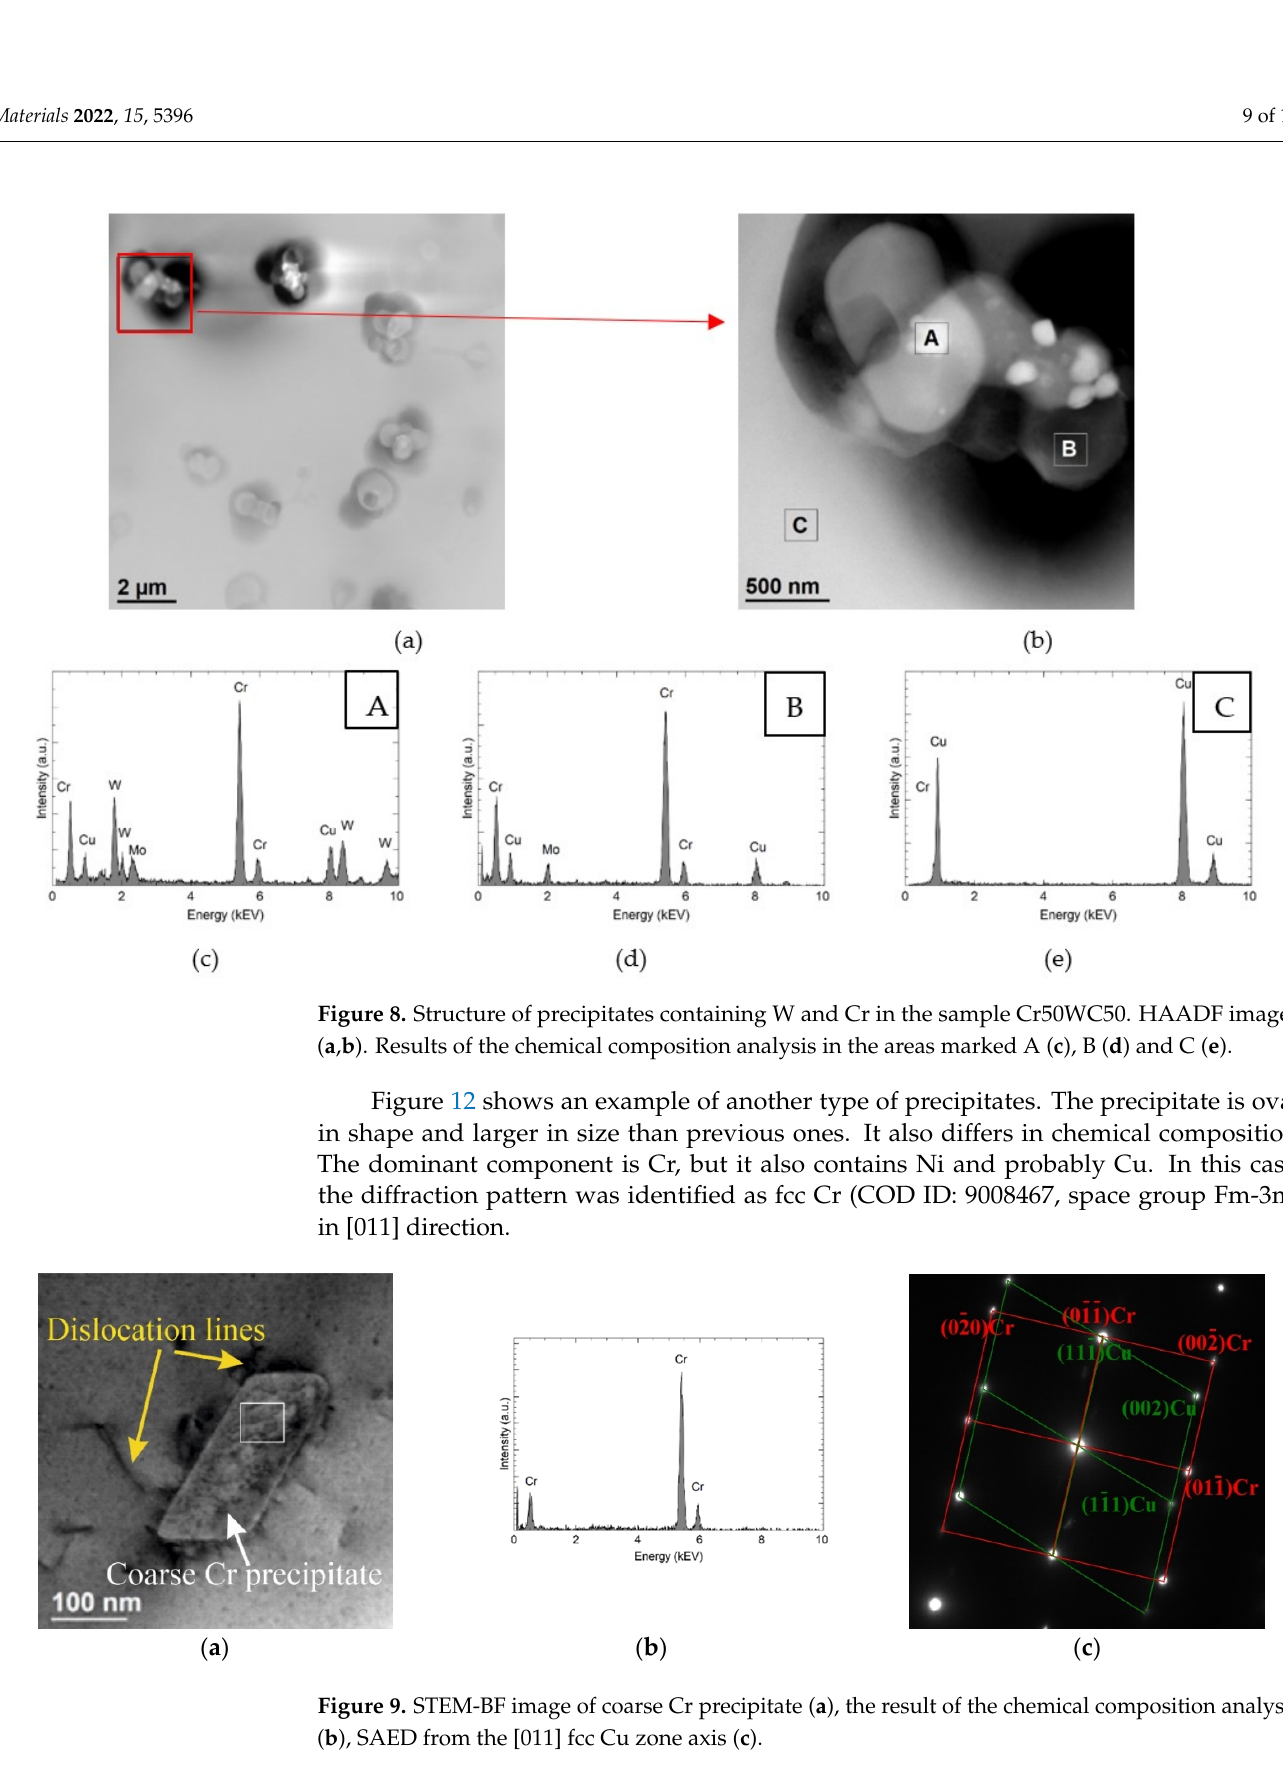
Figure 10. STEM-BF images of coarse Cr precipitates. The second group consists of precipitates rich in chromium and nickel. They are round in shape. Their size is about 50 nm. These precipitates are not visible in the STEM- BF images (Figure 11) and they are poorly visible in the HAADF images. The lack of dif- fraction contrast indicates that they are coherent with the Cu matrix. The weak Z contrast confirms the difference in the chemical composition of the precipitates compared to the matrix material. ( a )